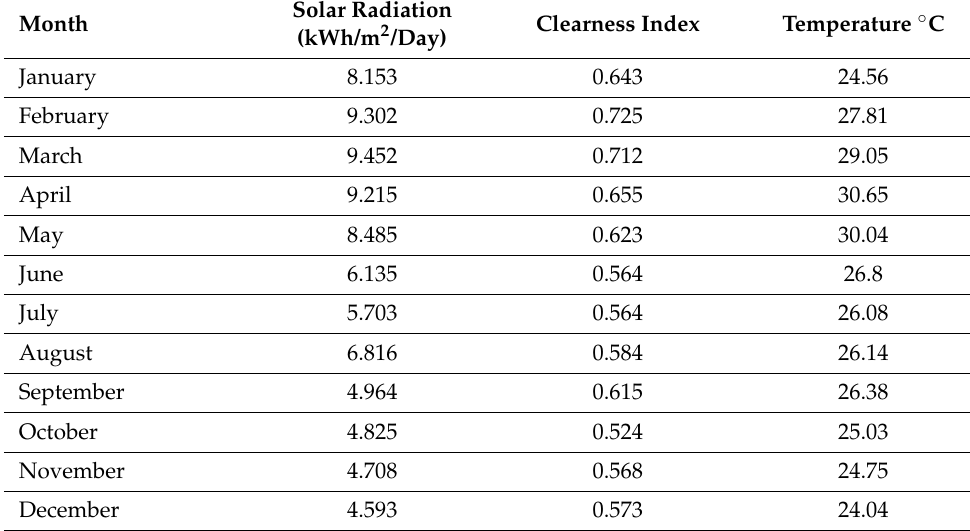
Table 3. Solar parameters of the site